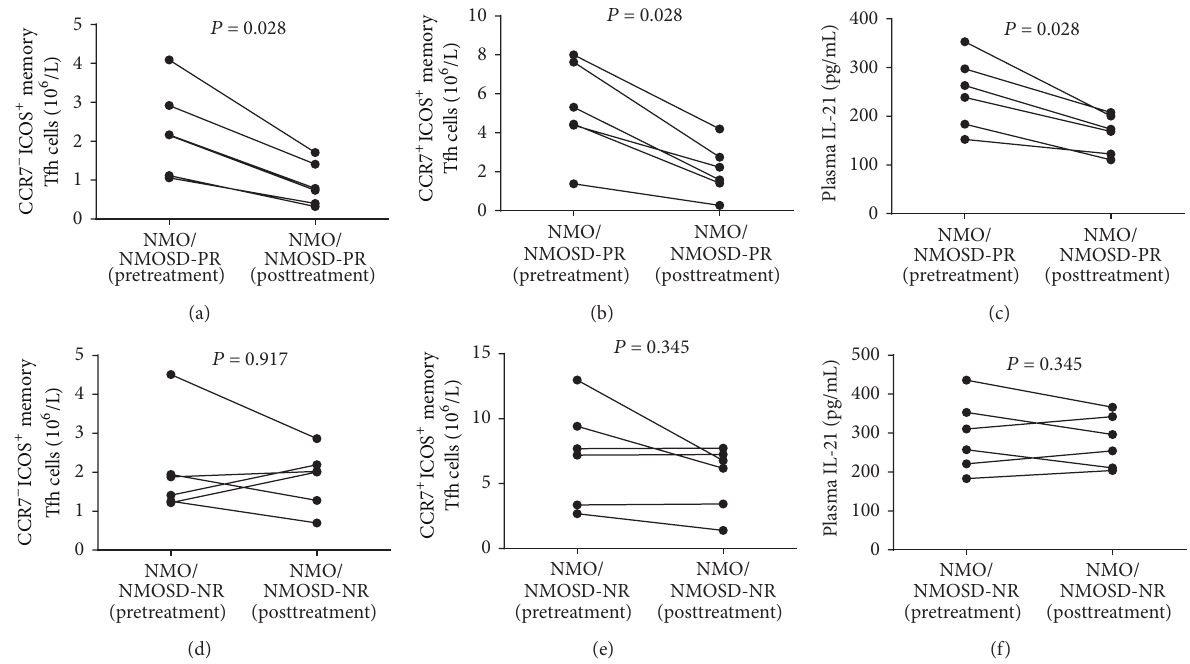
Figure 7: Changes in the numbers of different subsets of circulating memory Tfh cells and plasma IL-21 levels in NMO/NMOSD patients. Among 12 patients with posttreatment follow-up, six patients achieved partial remission (PR) and six patients showed nonremission (NR). The numbers of different subsets of circulating memory Tfh cells and the levels of plasma IL-21 were compared in patients with PR before and after treatment or patients with NR before and after treatment. ((a)-(b)) The numbers of CCR7 − ICOS + , CCR7 + ICOS + memory Tfh cells in CD4 + T cells in patients with PR before and after treatment. (c) The levels of plasma IL-21 in patients with PR before and after treatment. ((d)-(e)) The numbers of CCR7 − ICOS + , CCR7 + ICOS + memory Tfh cells among CD4 + T cells in patients with NR before and after